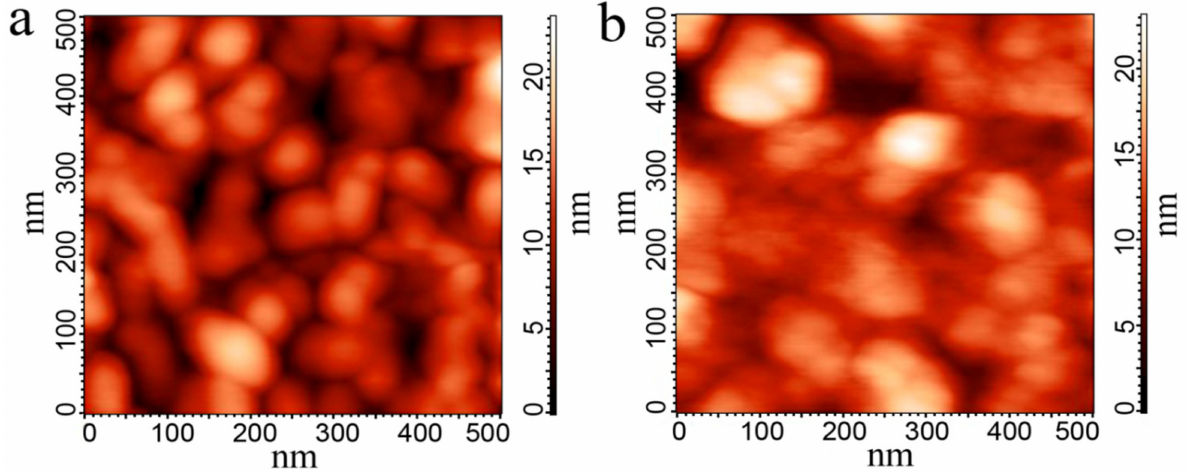
Figure 3. AFM images of the active layer of the Ag–FG–PVA–Si crossbar structures irradiated by Xe ions with the fluence of 3 × 10 11 cm − 2 and the energy of 26 MeV ( a ) and 167 MeV ( b ). The FG layer thickness is 7–10 ( a ) and 17–20 nm ( b